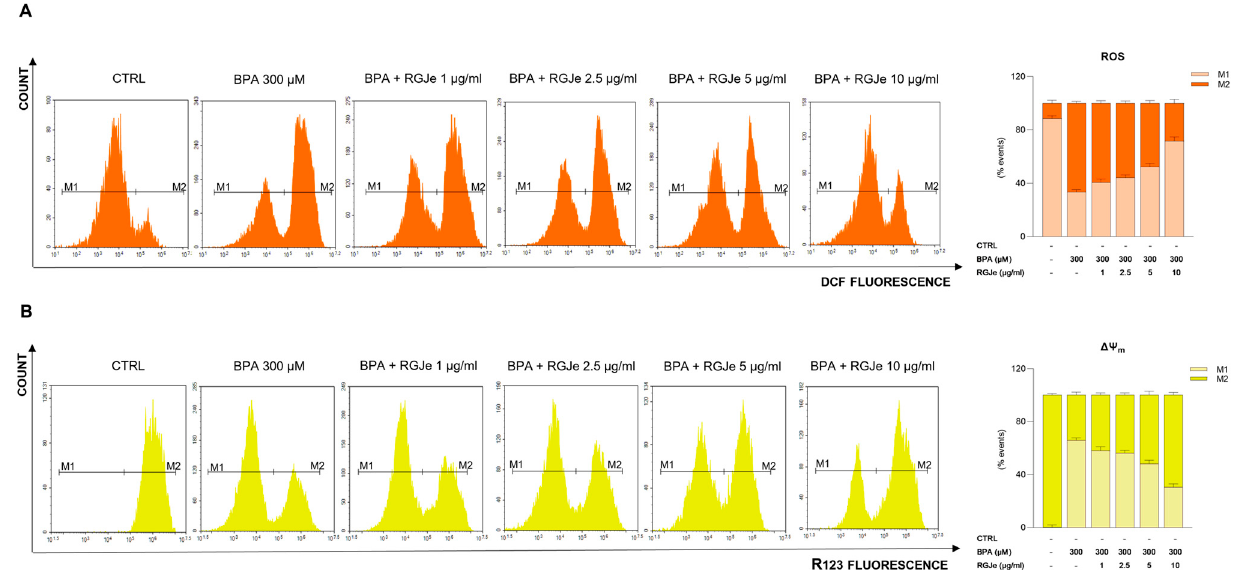
Figure 2. RGJe reduced both ROS generation and fall of ∆Ψ m induced by BPA in HUVECs. Cytofluorimetric evaluation of intracellular ROS ( A ) and mitochondrial membrane potential ( B ) was carried out employing DCFH-DA and R123 fluorescent probes, respectively. Representative plots of three independent experiments performed in triplicate (n = 9) are shown. For ROS detection ( A ) the histograms show the percentage ± SEM of healthy cells (DCF − , M1) and cells with increased intracellular ROS (DCF + , M2) of three separate experiments in triplicate (n = 9). For ∆Ψ m evaluation the histograms represent the percentage ± SEM of healthy cells (R123 + , M2) and the cells with impaired mitochondrial membrane potential (R123 − , M1) of three separate experiments in triplicate (n = 9).